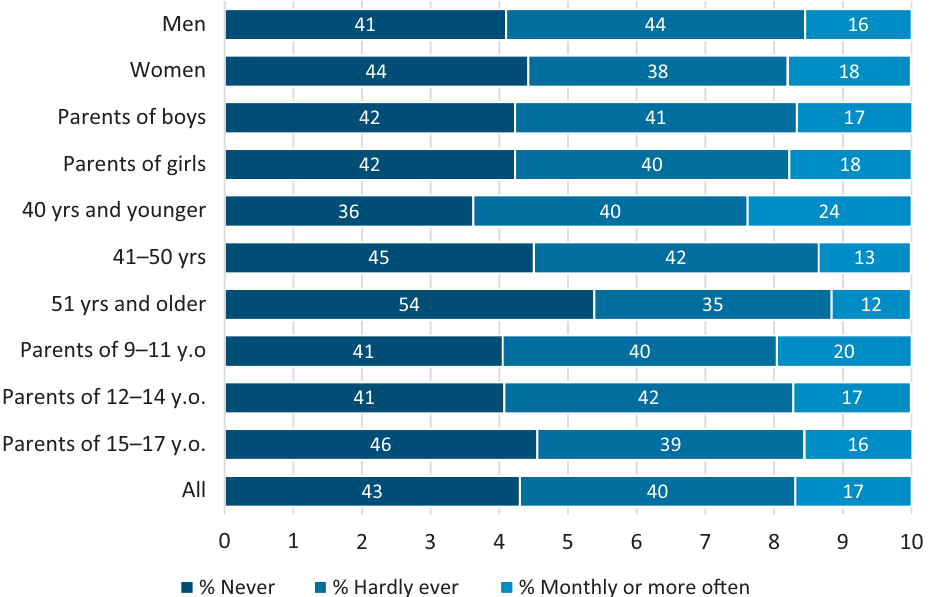
Parent digital skills